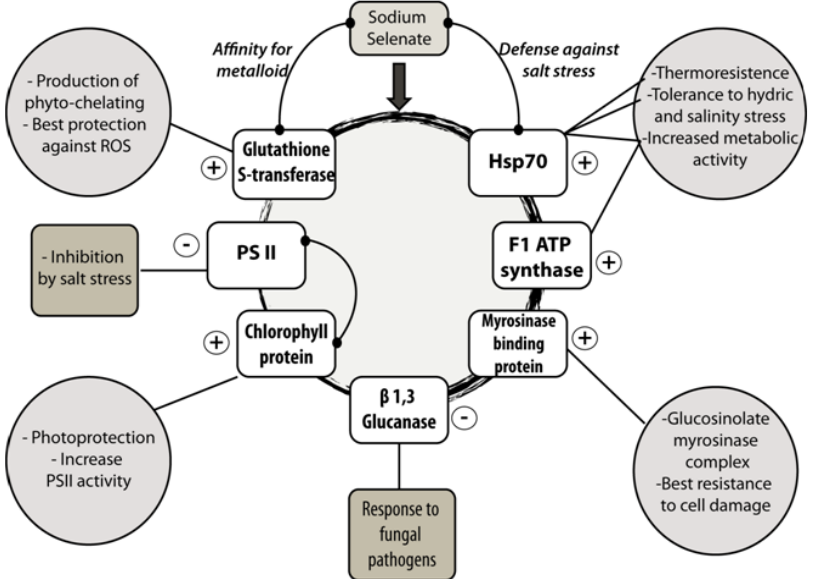
Figure 3. Representation of the main interactions between the proteins that exhibited significant differences in their synthesis with respect to the control condition, due to selenium